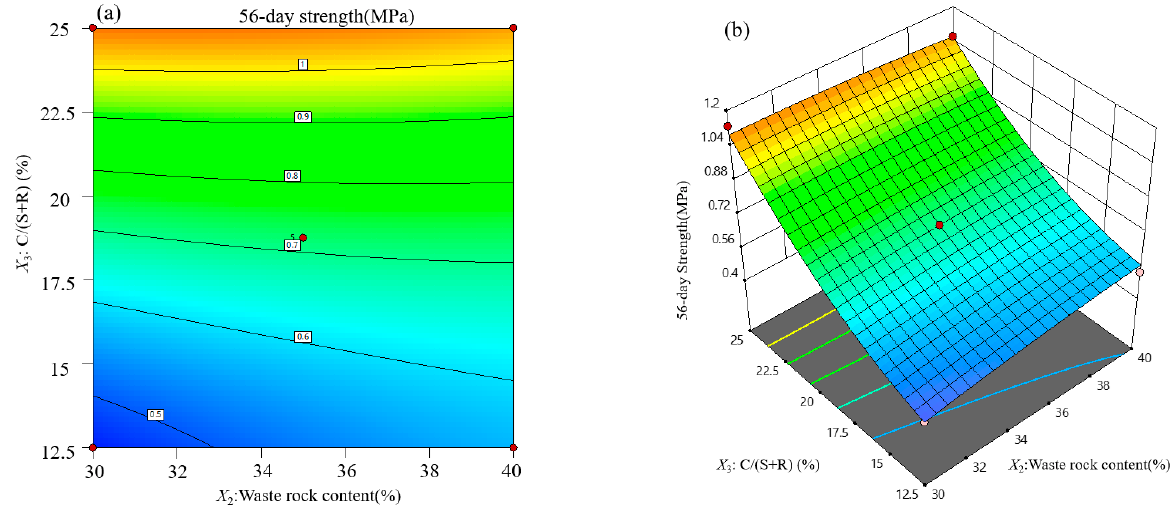
Figure 9. Response surface analysis of influential factors on backfill strength at 56 days: ( a ) contour lines; ( b ) response surface.